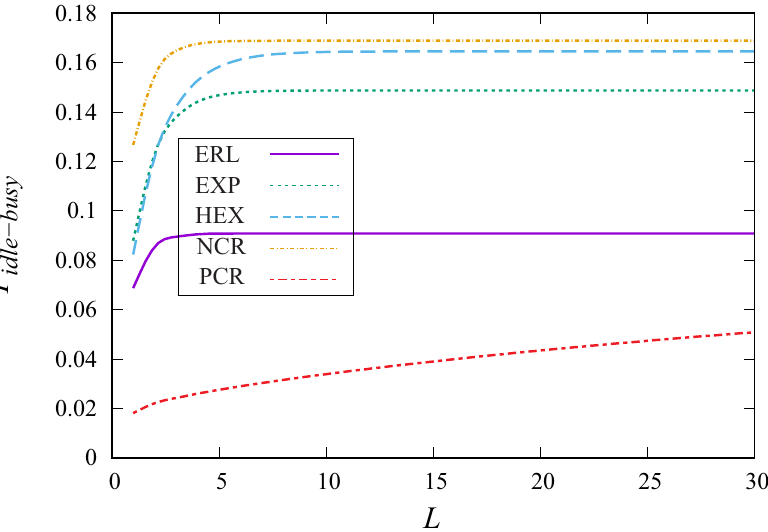
Figure 5. Dependence of the probability P idle − busy that the main server is idle while the secondary server is busy on the parameter L for different MAP